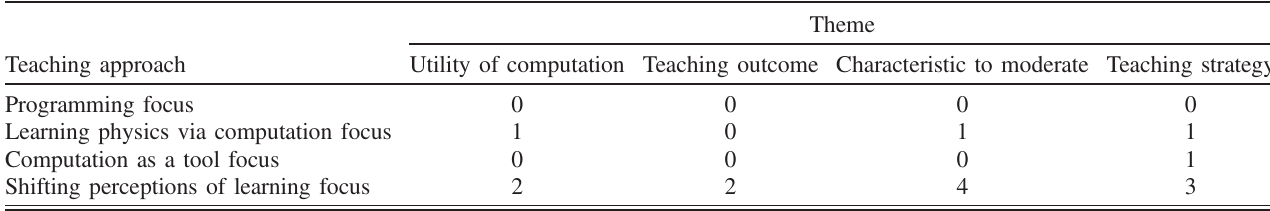
TABLE XIII. Analysis of Penelope ’ s teaching approach. The numbers indicate the amount of statements Penelope made aligned with each teaching approach, within each theme. For example, Penelope made five statements total within the characteristic to moderate theme. One was aligned with a learning physics via computation focus, and four were aligned with a shifting perceptions of learning